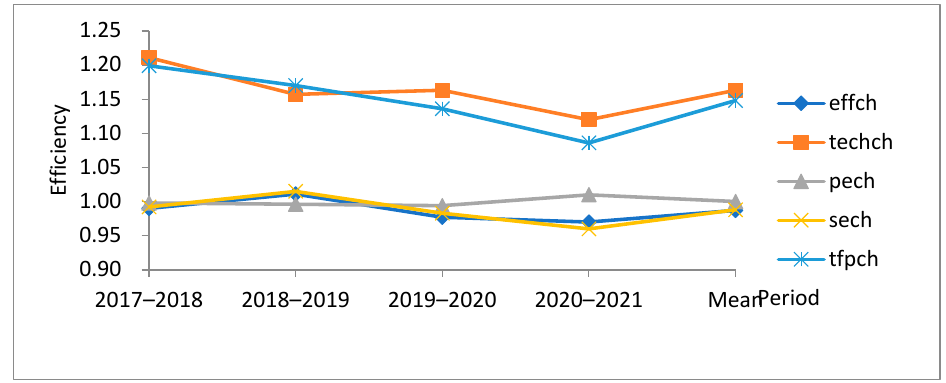
Figure 5. Malmquist Changing Tendency of Green Buildings’ Implementation Efficiency.